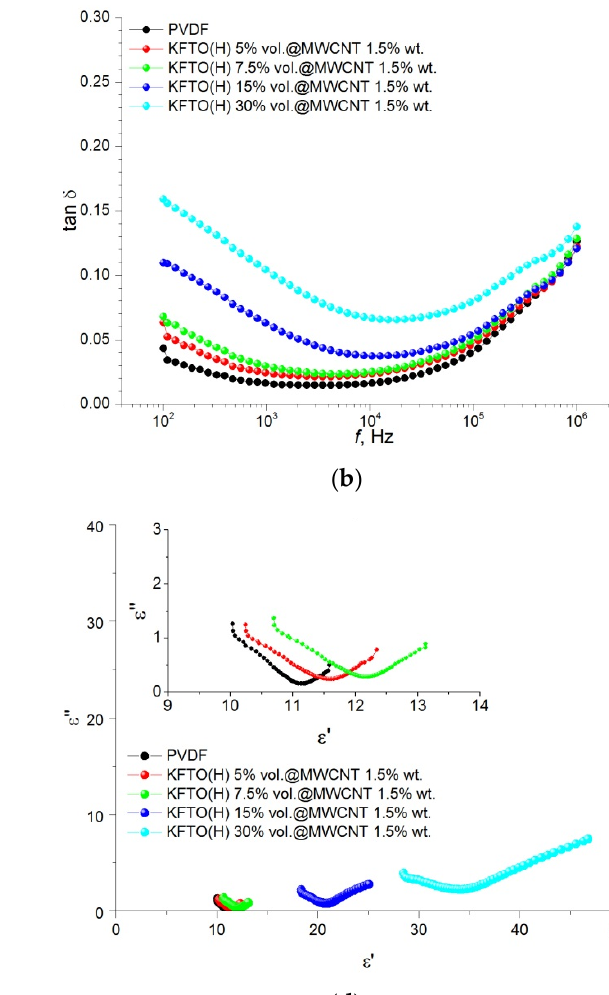
Figure 9. Frequency dependence of ( a ) permittivity, ( b ) dielectric loss tangent, ( c ) conductivity and ( d ) Cole–Cole plot ( ε ′ – ε ″ ) for PVDF-based composites with different volume fractions of KFTO(H) with MWCNT additive of 1.0 wt.% (inset is the enlarged view of the basic figure).